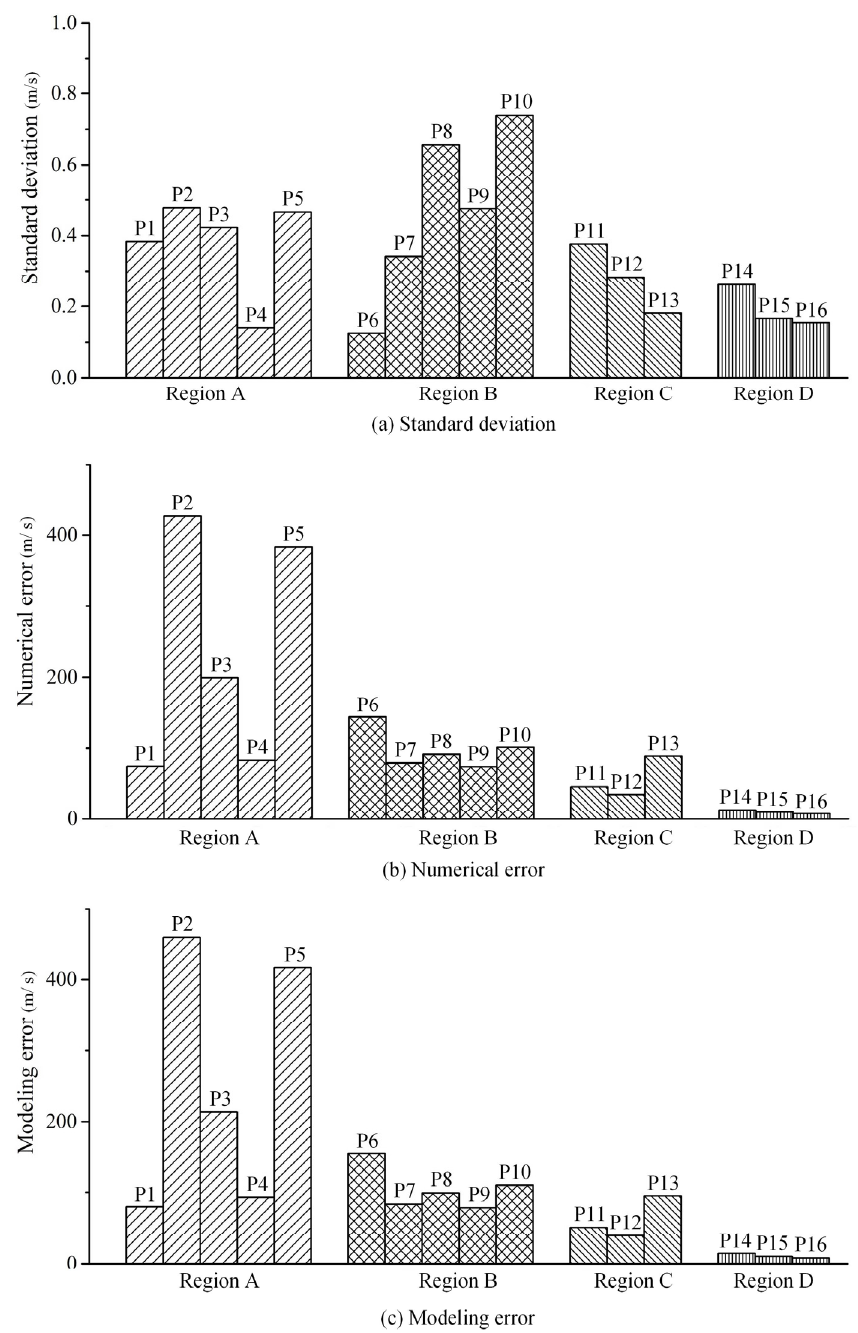
Figure 7. Distribution of the LES errors and standard deviations in different region.